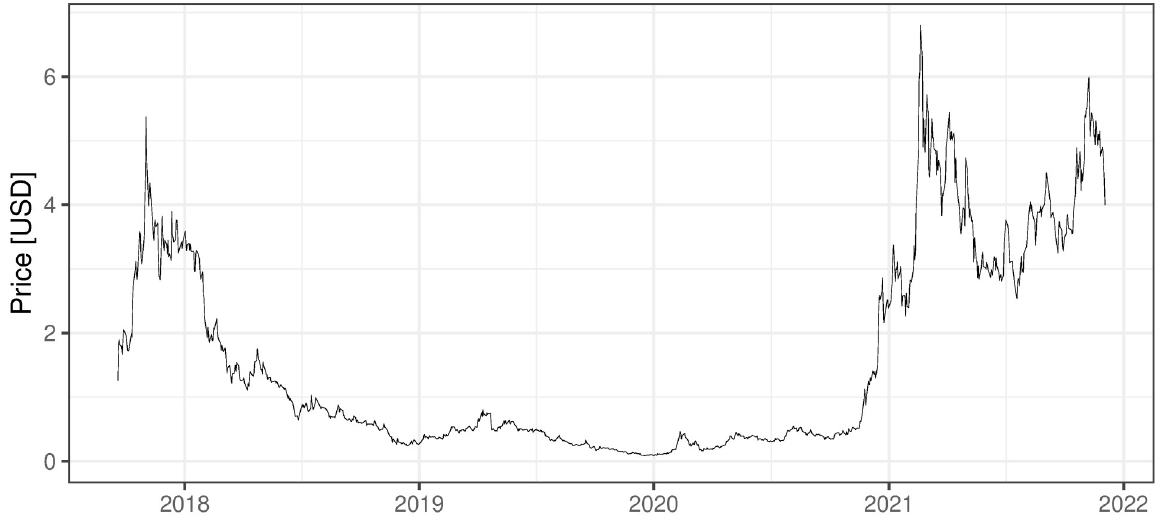
Fig 5. The daily fluctuations of HIVE Blockchain prices on TSE. Source: https://finance.yahoo.com/quote/HIVE.V/chart?p=HIVE.V (downloaded on 2021/12/03).